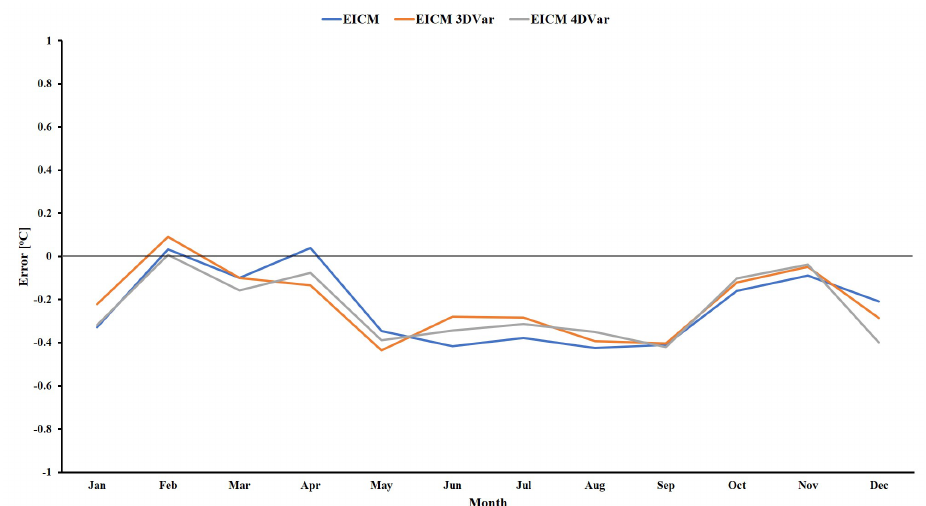
Figure 10. Mean monthly systematic error of the SSTA ( ◦ C) calculated from the EICMDA and EICM